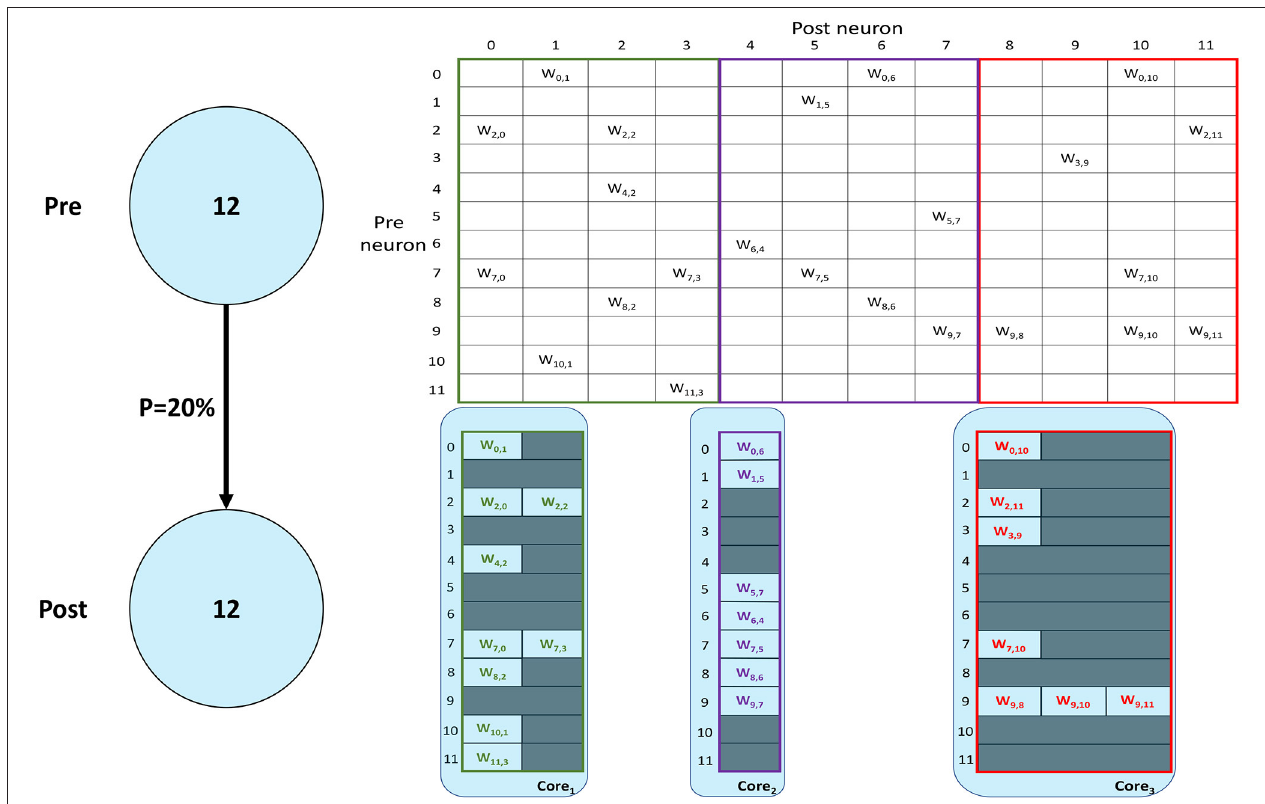
FIGURE 2 | Synaptic matrix partitioning under the homogeneous partitioning. The presented matrix comes from an example network composed of 2 populations having 12 neurons each with 20% connectivity (schematic on the left). The full synaptic matrix is shown on top right. The sparse representation partitioned into 3 different cores is shown on bottom right (with colors matching the full synaptic matrix). The partitioning assumes a limit of 4 neurons per core, therefore 3 cores are